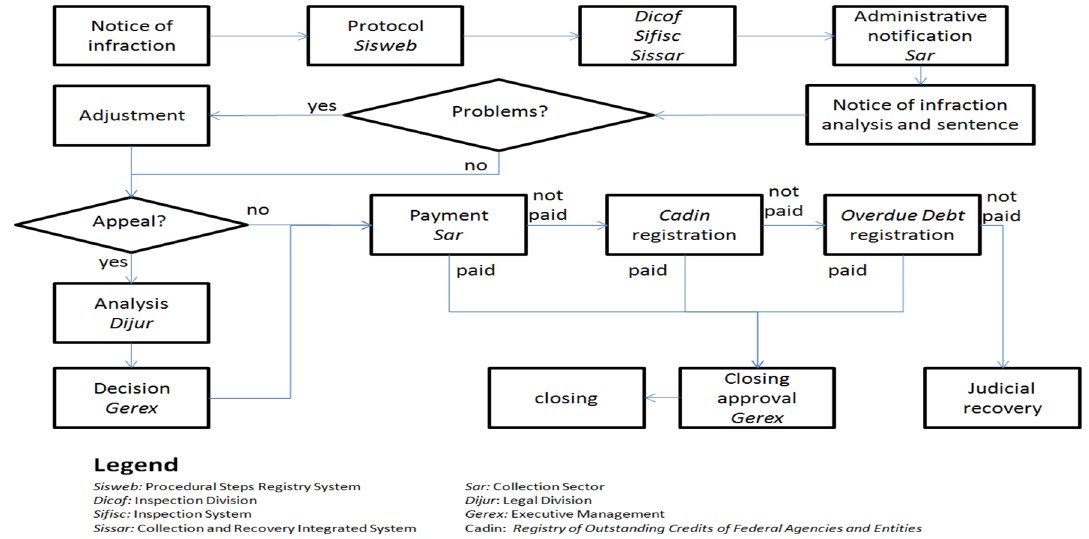
Figure 2. Steps for fine collection in IBAMA. Source: adapted from [32].